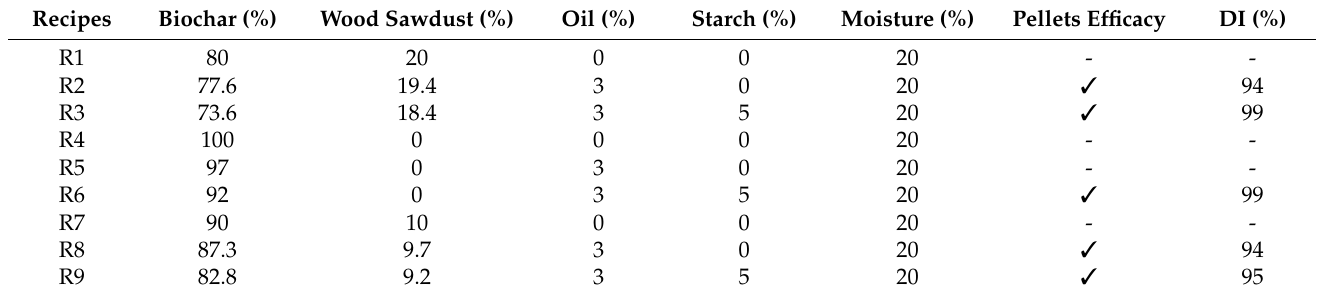
Table 1. Composition of the experimental pellets, efficacy and durability index